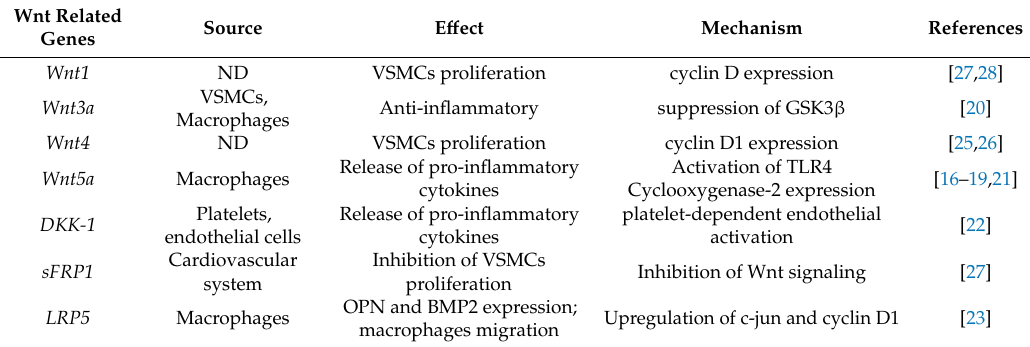
Table 1. Implication of Wnt related gene in atherosclerotic